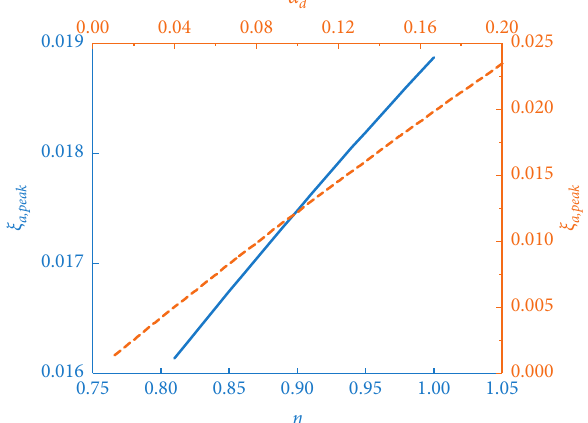
Figure 6: Variations of the peak damping ratio ξ to α b and η